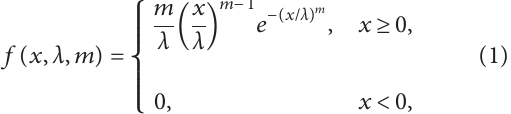
Figure 2: Stress-strain curves of Beishan granite for direct tensile test.